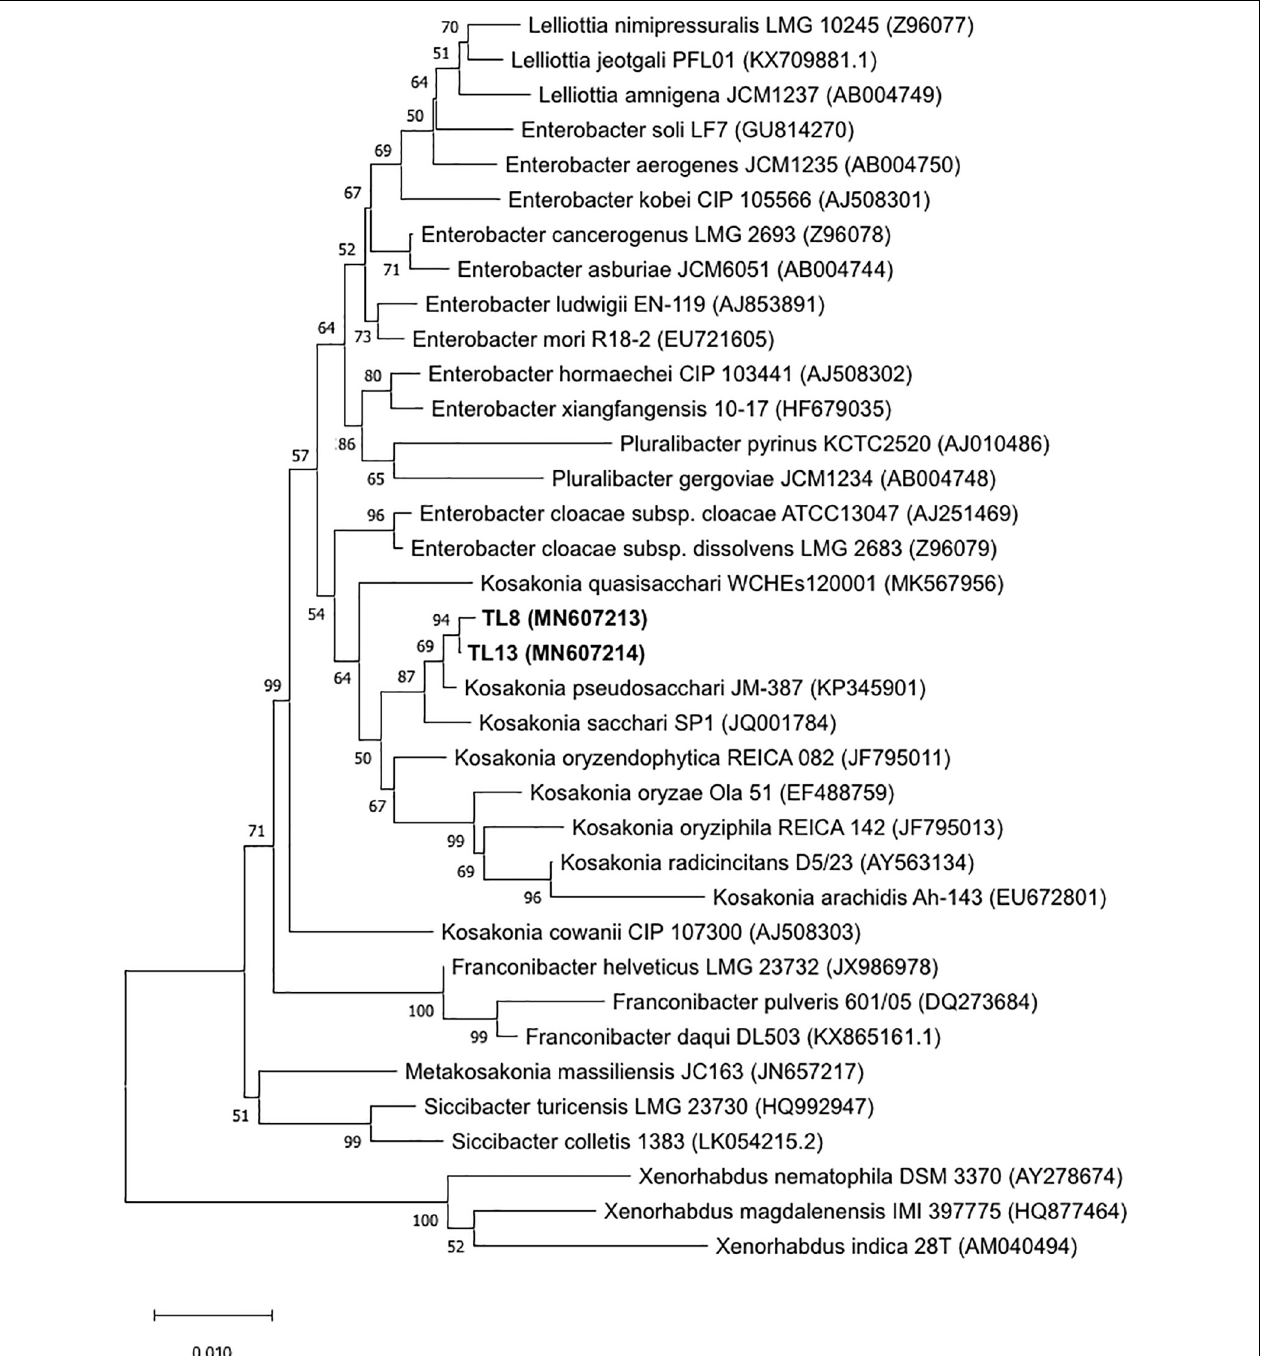
FIGURE 1 | Neighbor-Joining tree based on the comparison of 16S rRNA gene sequences of bacterial strains TL8 and TL13 and 31 type strains related to genus Kosakonia sequences from RDP and NCBI. Bootstrap values (expressed as percentages of 1,000 replications) are given at the nodes. The sequence accession numbers used for the phylogenetic analysis are shown in parentheses following the species name. Xenorhabdus type strain sequences were used as out group. The scale bar estimates the number of substitutions per site.